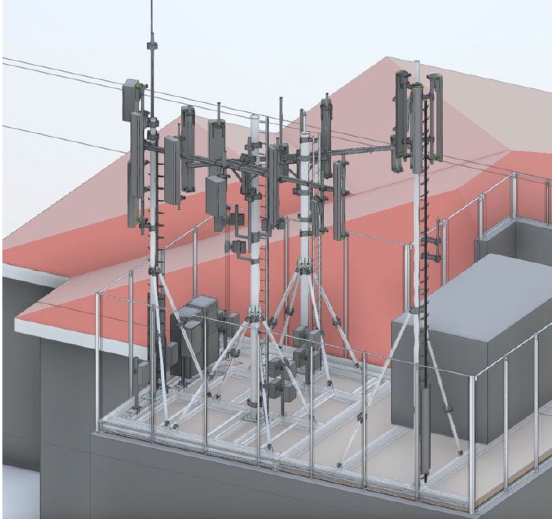
Figure 1. Axonometric view of the BIM representation of one of the sites managed by INWIT (screenshot taken from the Autodesk Viewer web service).